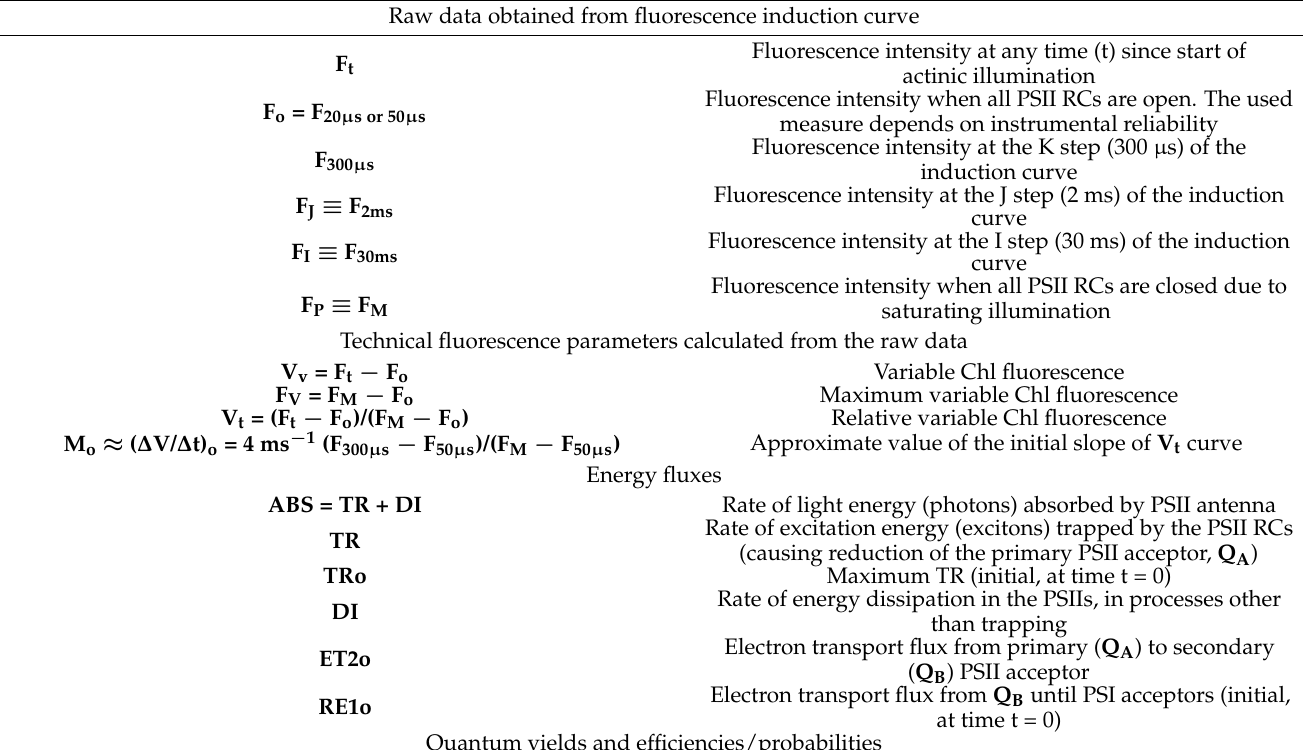
Table 1. Nomenclature and formulae of the OKJIP transient and related JIP test parameters (modified after